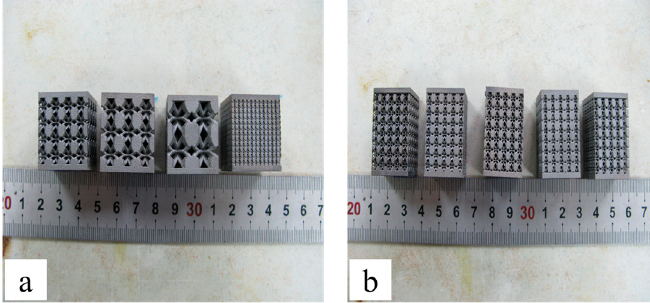
Figure 2. Two group specimens of porous structures manufactured by selective laser melting (SLM) for compression tests: ( a ) specimens with a unit cell size of 2 mm and different porosity of 40%, 50%, 60%, 70% and 80%; ( b ) specimens with a porosity of 60% and different cell sizes of 1, 2, 3, 4 and 6 mm.